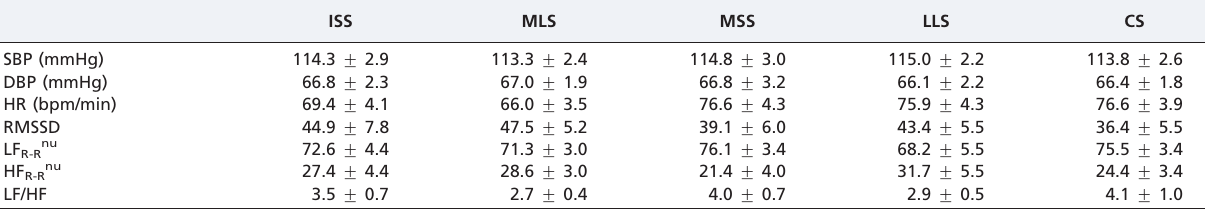
Table 3 - Hemodynamic parameters and pre-exercise autonomic indicators.